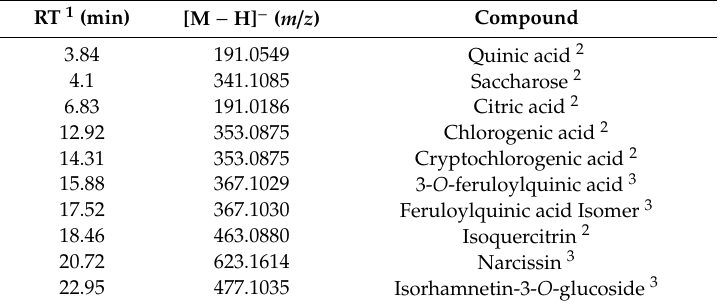
Table 1. Some of the major constituents of the methanolic extract of Bupleurum rotundifolium roots.